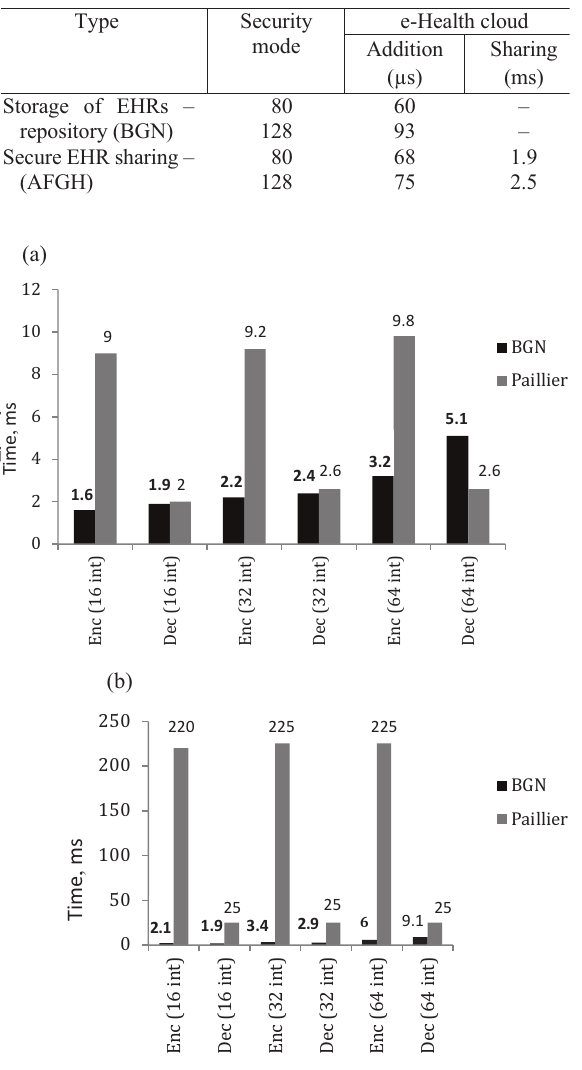
Table 3. Performance summary – cloud